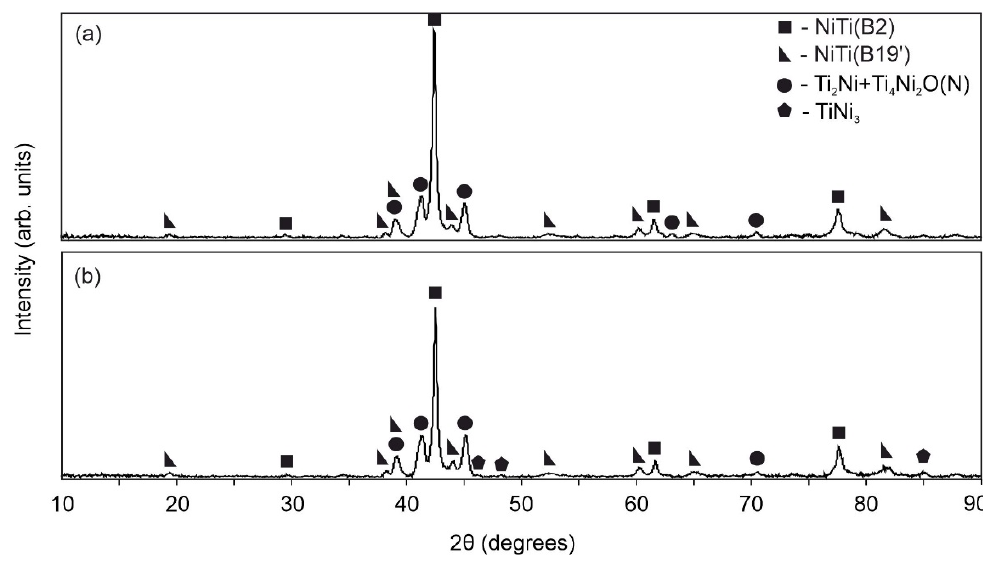
Figure 5. X-ray diffractograms of porous NiTi-(Ar) ( a ) and NiTi-(N) ( b ) samples obtained by the SHS. Table 1. XRD data from the surface of porous NiTi-(Ar) and NiTi-(N) samples. Vol. Fraction, Lattice Sample Phase CSR, nm ∆ d/d × 10 − 3 vol.% Parameter, Å NiTi (B2) NiTi-(Ar)